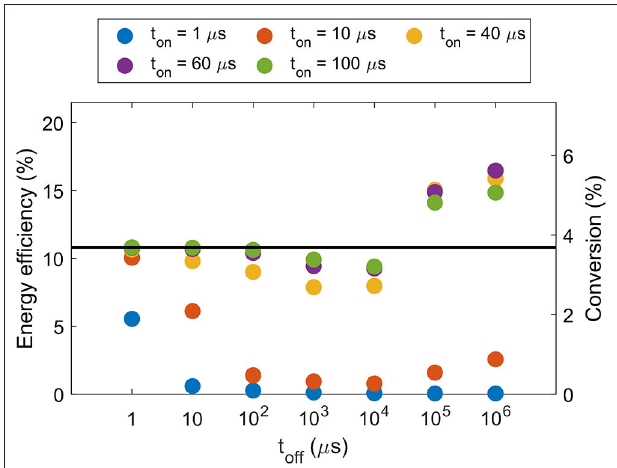
FIGURE 9 | Calculated energy efficiency and conversion in a pulsed MW plasma, as a function of interpulse time (t off ), for five different pulse-on times (t on ), at an SEI of 1 eV/molec and a pressure of 100 mbar. The horizontal line represents the conversion and energy efficiency of a continuous plasma at the same SEI value. Adopted from Vermeiren and Bogaerts (2019) with